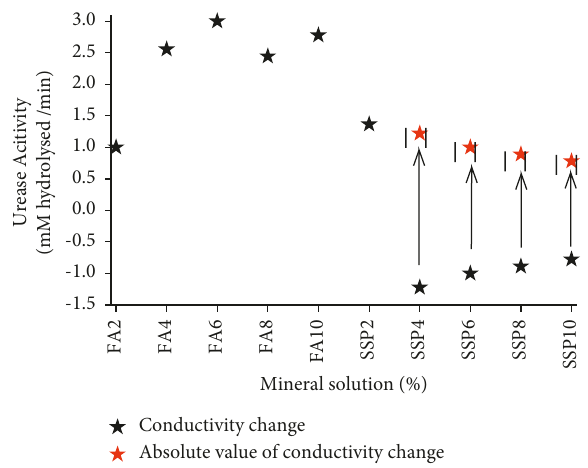
Figure 6: Urease activity of the bacteria in different mineral